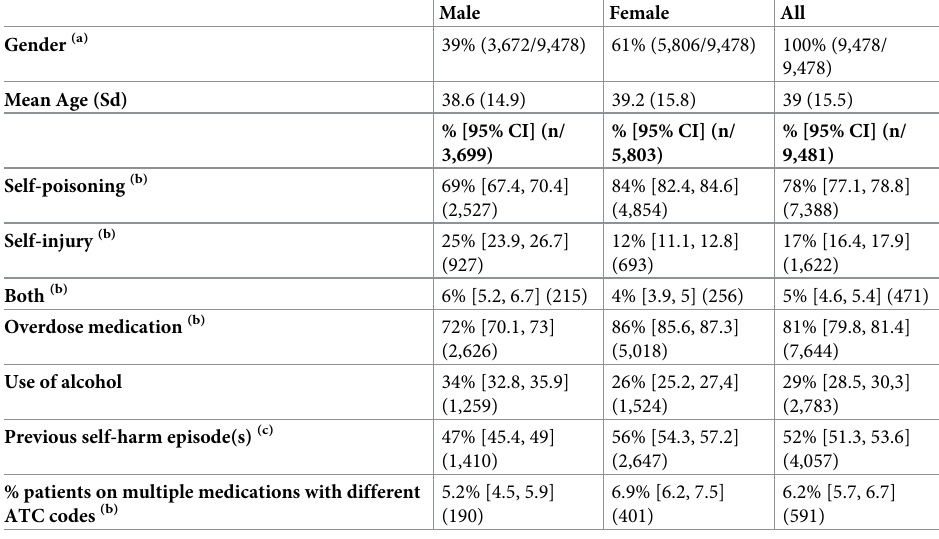
(a) For 9 episodes gender was not known, thus total number of episodes 9,487 (b) Method unknown for 3 males and 3 females (c) Previous self-harm episodes unknown for 682 males and 1,056